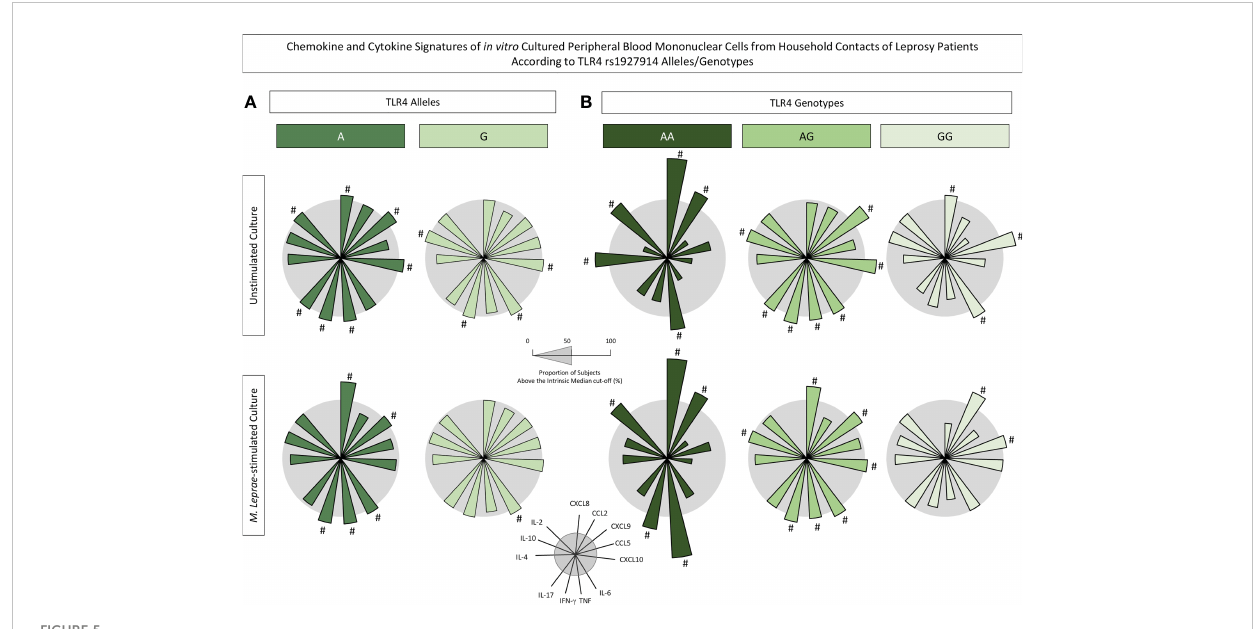
FIGURE 5 Chemokine and cytokine signatures of in vitro cultured peripheral blood mononuclear cells from household contacts of leprosy patients according to TLR4 rs1927914 alleles/genotypes. The levels of chemokines (CXCL8, CCL2, CXCL9, CCL5, CXCL10) and cytokines (IL-6, TNF, IFN- g , IL-17, IL-4, IL-10 and IL-2) were measured in the supernatant collected upon in vitro culture of PBMC from household contacts of leprosy patients categorized according to the TLR4 rs1927914 alleles/genotypes as follows: (A) A